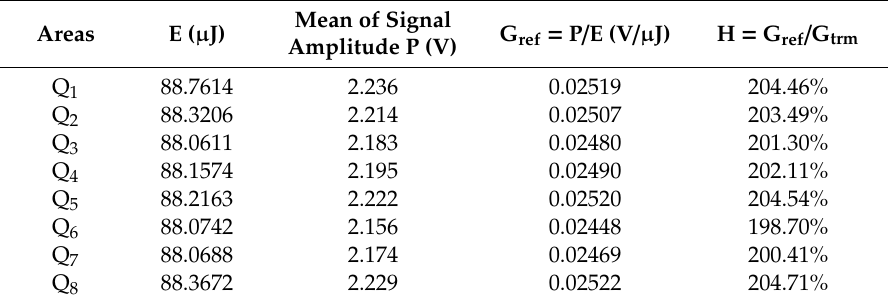
Table 1. The ultrasonic reflection e ffi ciency of the quartz bowl.